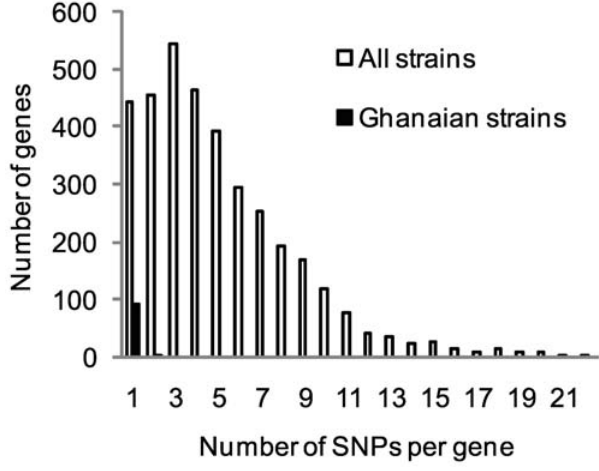
Figure 3. Distribution of number of SNPs per gene.